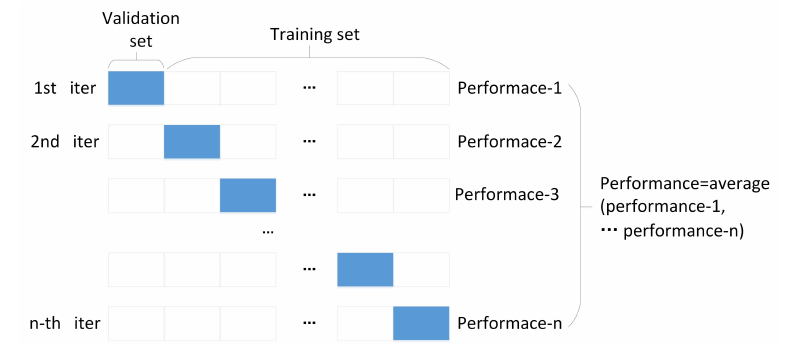
Figure 2. Process of the leave-one-outcross